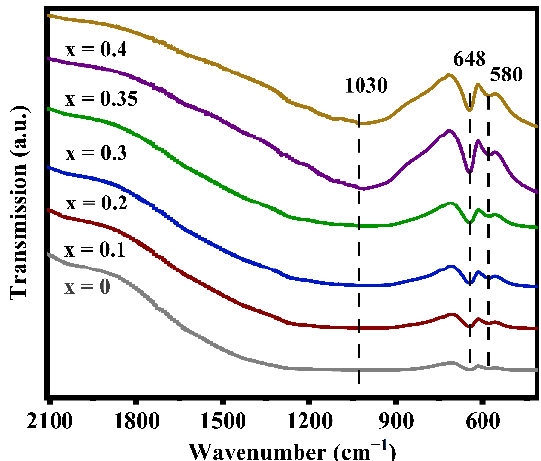
Figure 3. FT-IR spectra of LATP-xSn (x = 0–0.4) solid electrolytes.